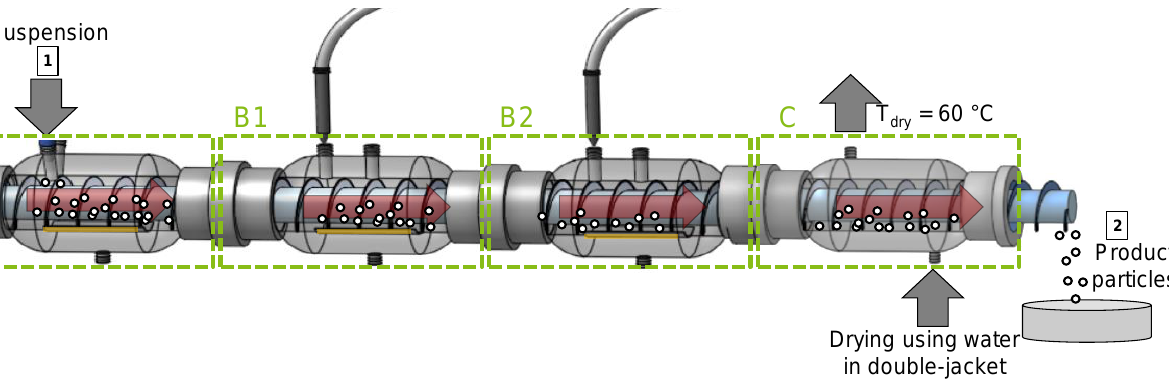
Figure 7. Experimental setup of the experiments with varying particle